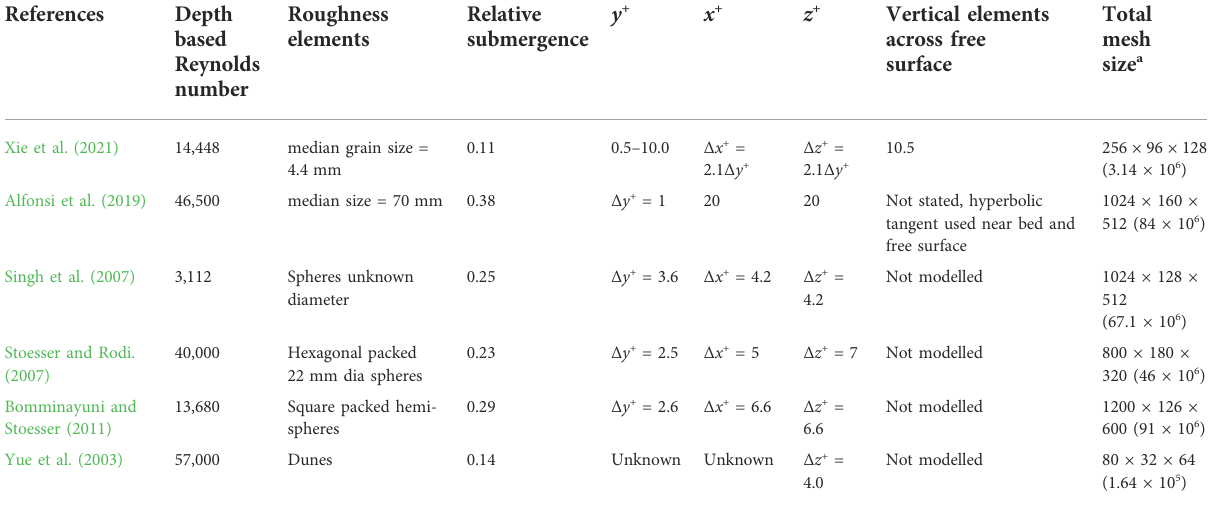
TABLE 2 Summary of rough bed simulations and CFD